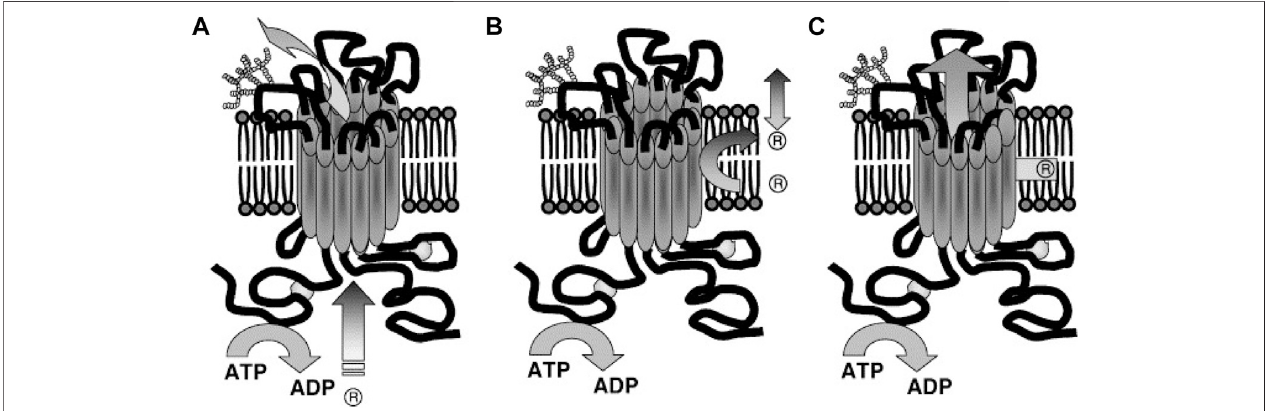
FIGURE 7 | Suggested Models illustrating P-gp mechanisms of drug ef fl ux. (A) Classical or pore, (B) fl ippase and (C) hydrophobic vacuum cleaner models. In the classical model: substrate ef fl uxes out of the cell through a protein channel by interacting with P-gp in the cytoplasm. In the fl ippase model: substrate transports into the innerlea fl et,bindstoP-gp(withinthemembrane),translocatestotheouterlea fl et,andpassivelydiffusesintotheextracellular.Inthehydrophobicvacuumcleanermodel: the characteristics of ‘ pore ’ and ‘ fl ippase ’ models are mixed (Li et al., 2007).